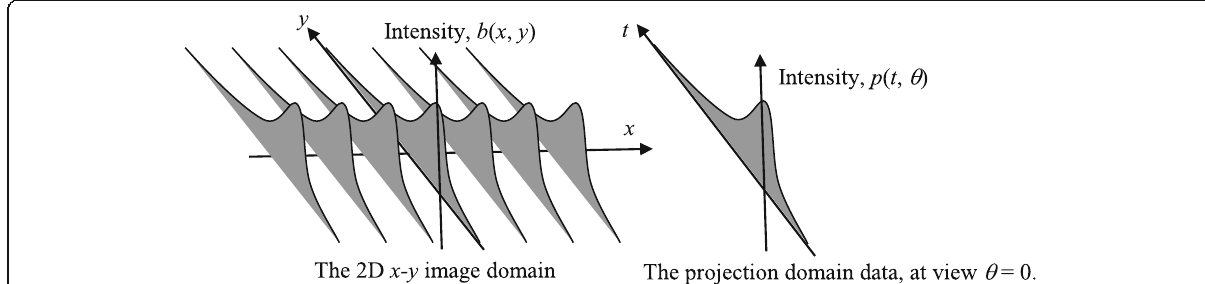
Fig. 3 The conventional two-dimensional backprojection for the parallel-beam geometry. The conventional backprojection copies the function along the projection direction throughout the entire image space